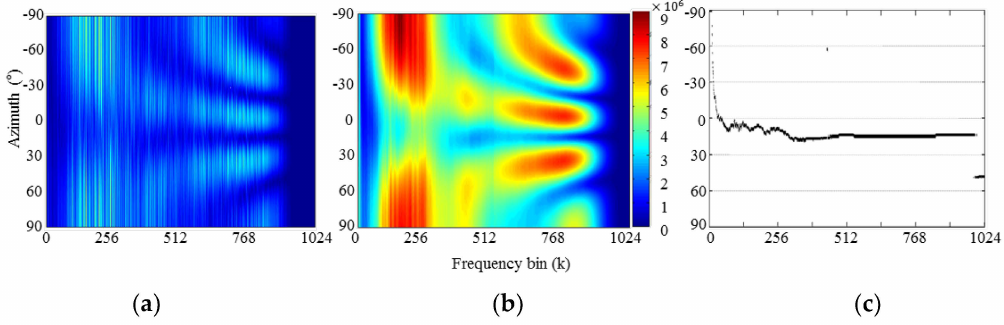
Figure 5. A-F planes and estimated direction for white noise in a reverberant room with RT 60 = 230 ms: